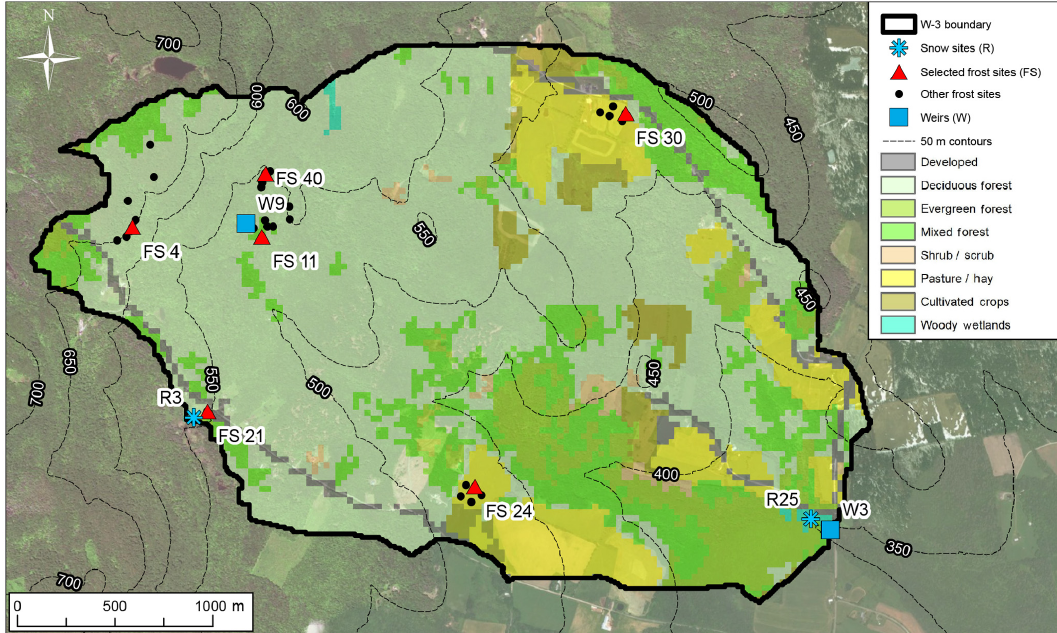
Figure 1. W-3 sub-basin in the Sleepers River experimental watershed. Sites used in this study are identified with red triangles and blue snowflakes. Basin delineation and elevation contours (m) are based on the 1/3arcsec National Elevation Dataset, land cover classification is based on the 2006 National Land Cover Database, and sources of the background imagery include ESRI, DigitalGlobe, Earthstar Geograph- ics, CNES/Airbus DS, GeoEye, USDA FSA, USGS, Getmapping, Aerogrid, IGN, IGP, and the GIS User